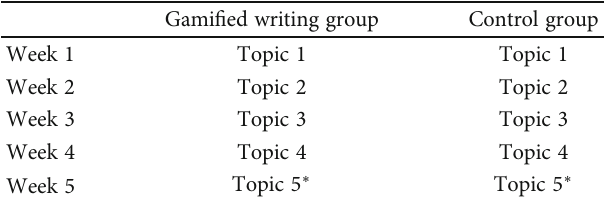
Table 1: Research arrangement